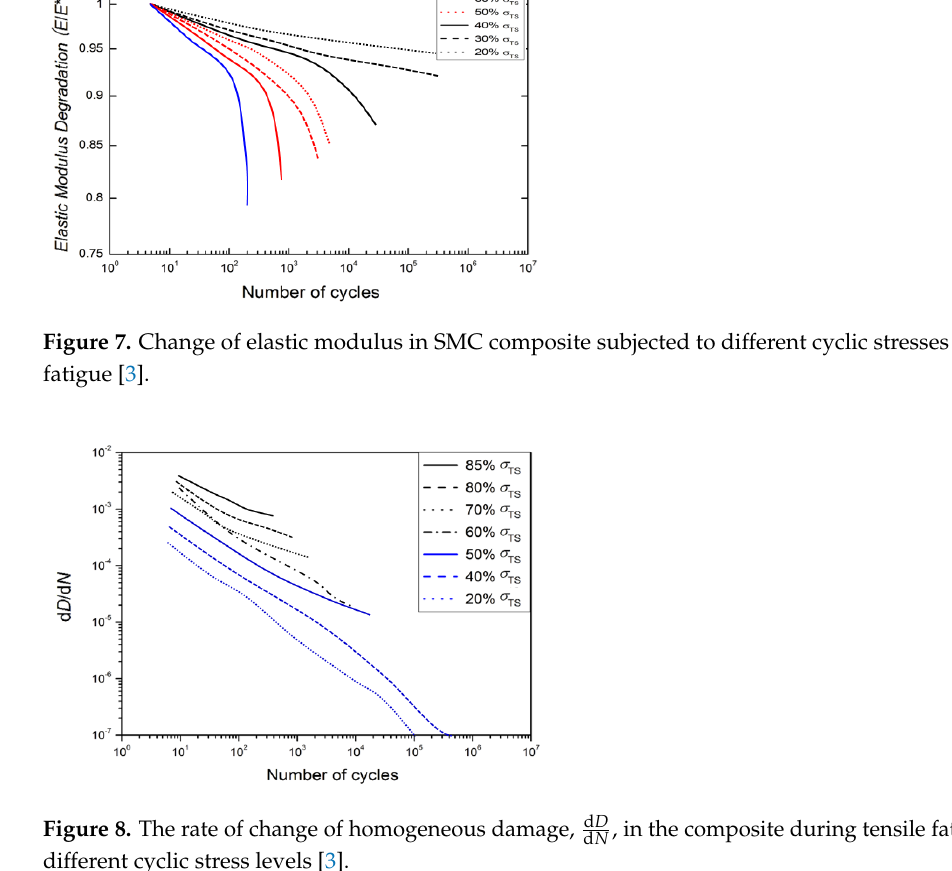
, in the composite during tensile fatigue at (cid:2914)(cid:3015) d N